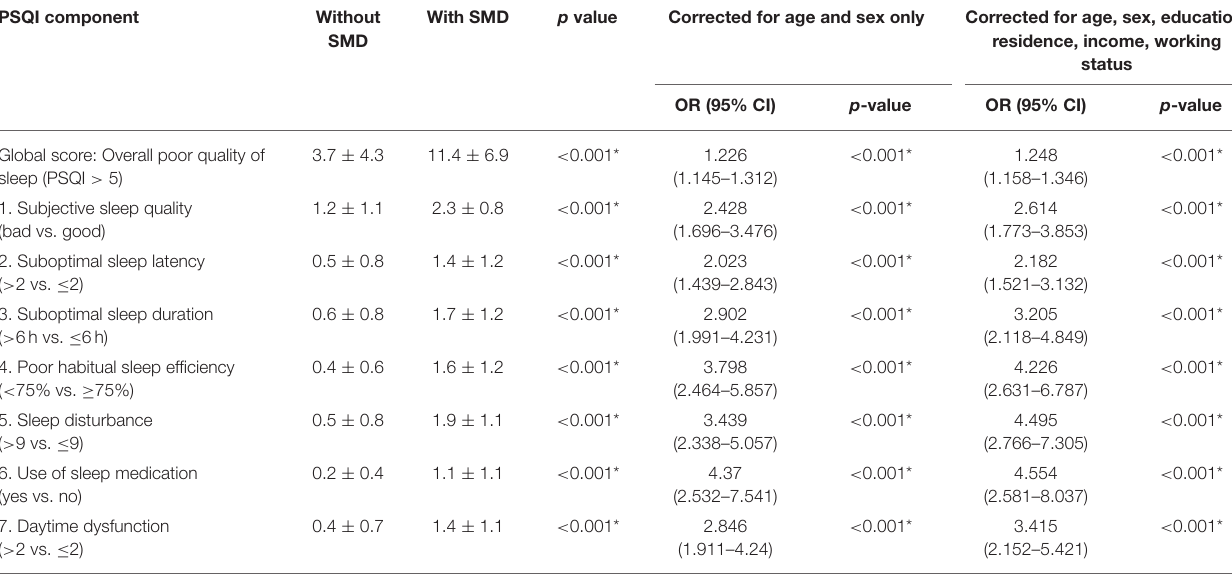
TABLE 3 | Association between sleep quality (all components of the PSQI) and MG dropout. PSQI component Without With SMD p value Corrected for age and sex only Corrected for age, sex, education, SMD residence, income, working status OR (95% CI) p -value OR (95% CI) p -value Global score: Overall poor quality of sleep (PSQI >